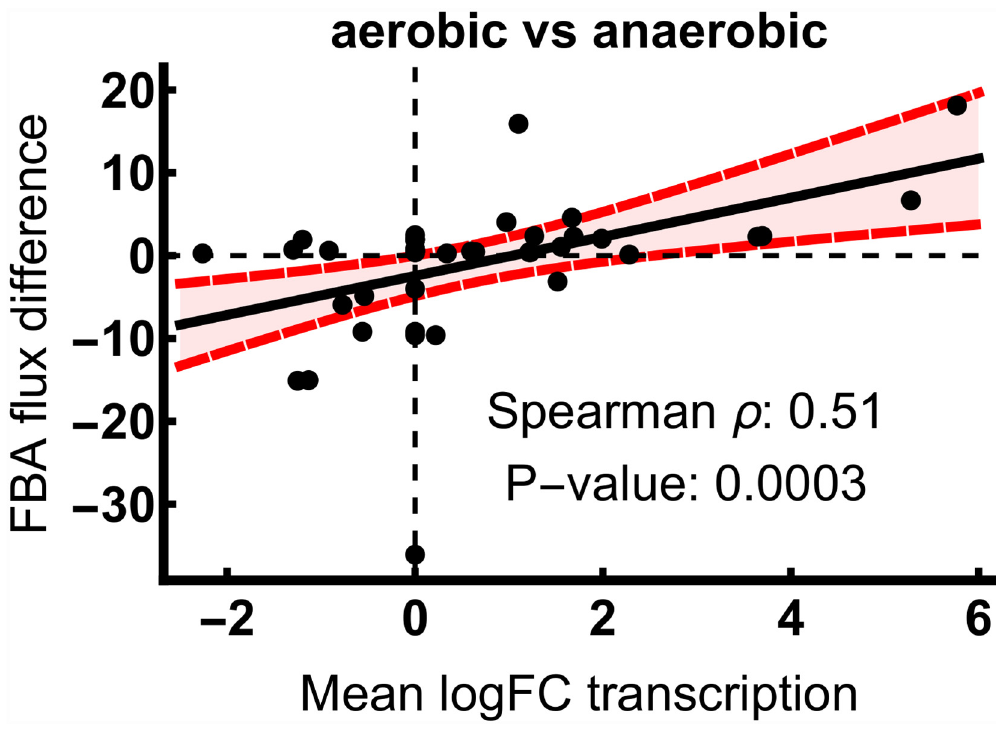
Fig 2. Correlation of transcriptional fold changes with FBA flux rate differences. The difference between the sums of absolute FBA fluxes with identical enzyme composition between anaerobic and aerobic conditions is plotted against the logFC of the associated transcripts. Spearman rank coefficient and P-values are indicated. Linear regression is shown as black line with 95% confidence bands in